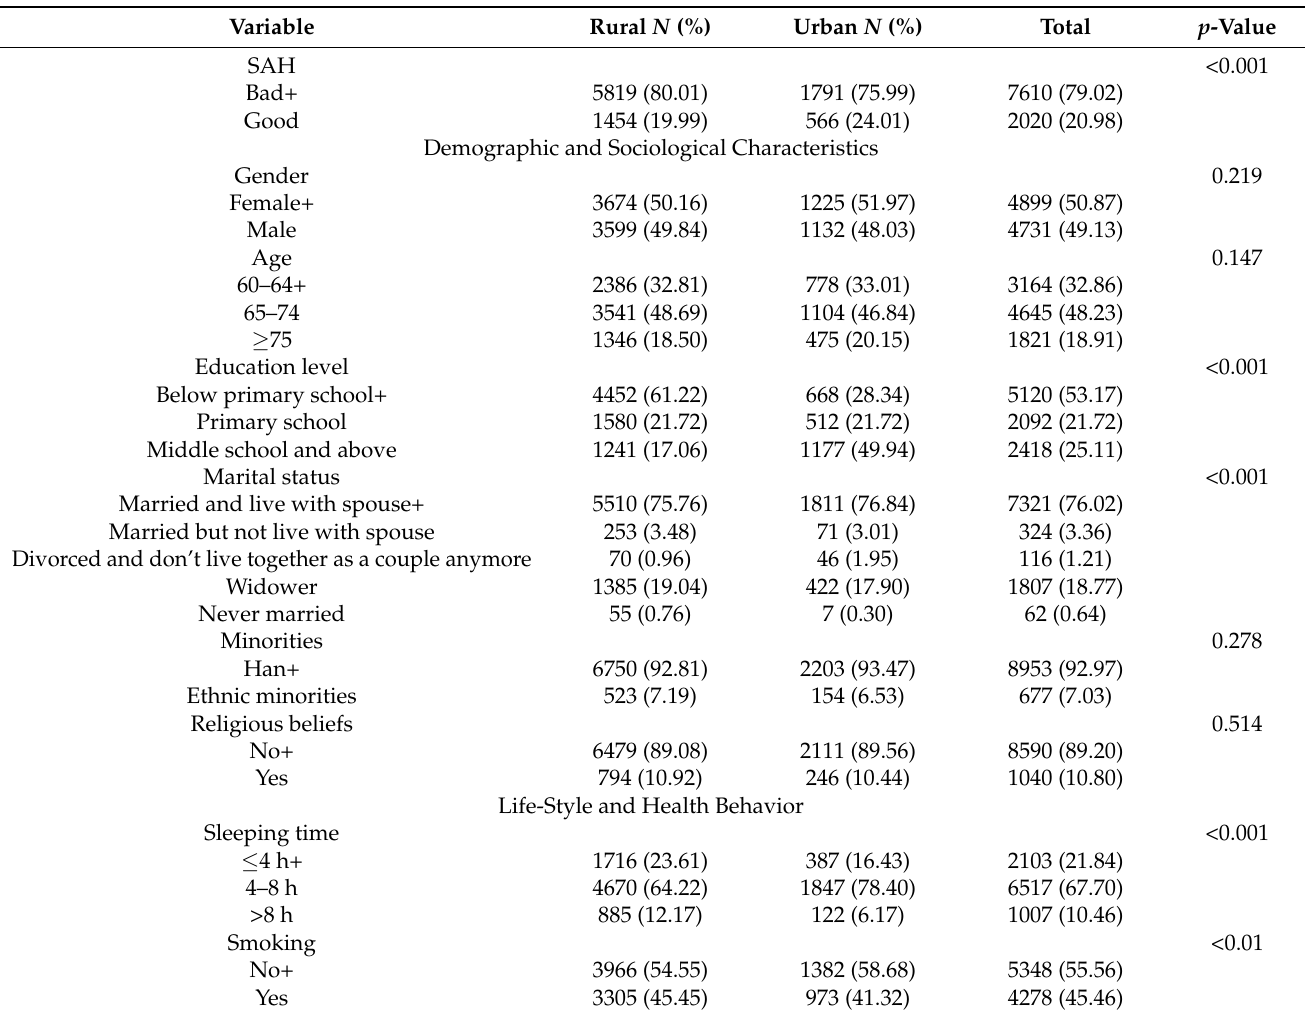
Table 2. Descriptive statistics of